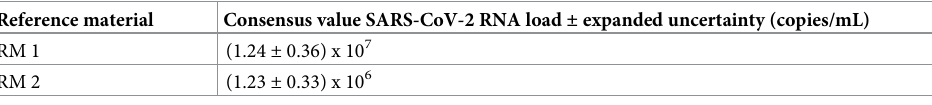
Table 1. Consensus values of the RT-dPCR analyses by three NMIs, reported as the overall mean and its 95%-CI of the three NMI-specific results. Reference